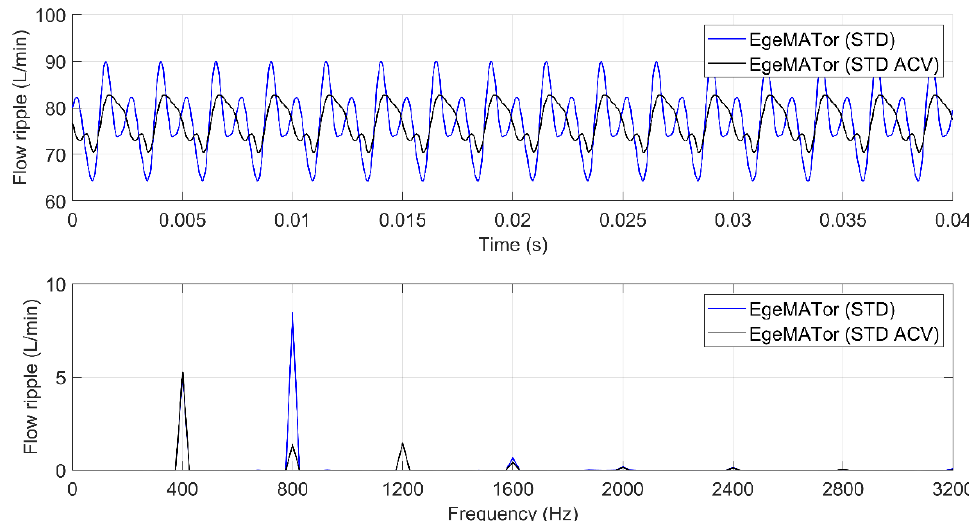
Figure 16. Standard vs. ACV (no gap), outlet flow ripple at 1500 rev/min and 230 bar in time and frequency domains.